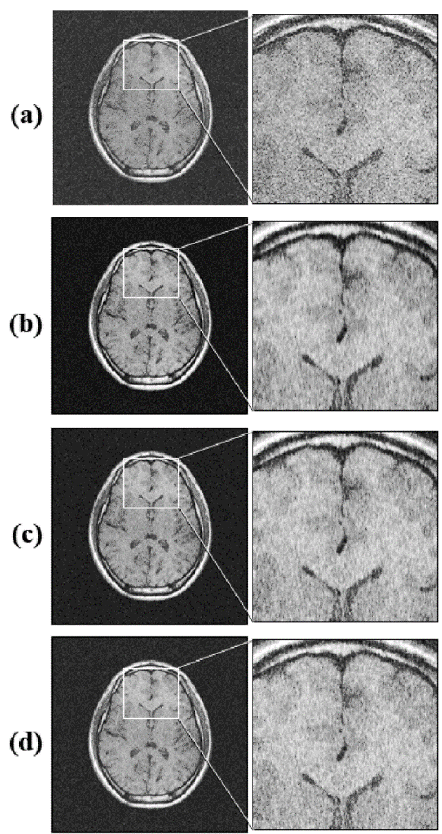
Figure 2. Simulation for k-space undersampling effects. ( a ) A full sampling image; ( b ) image reconstructed from the 25% undersampling mask applied to the full sampling dataset; ( c ) image reconstructed from the 35% undersampling mask applied to the full sampling image; ( d ) image reconstructed from the 45% undersampling mask applied to the full sampling image.